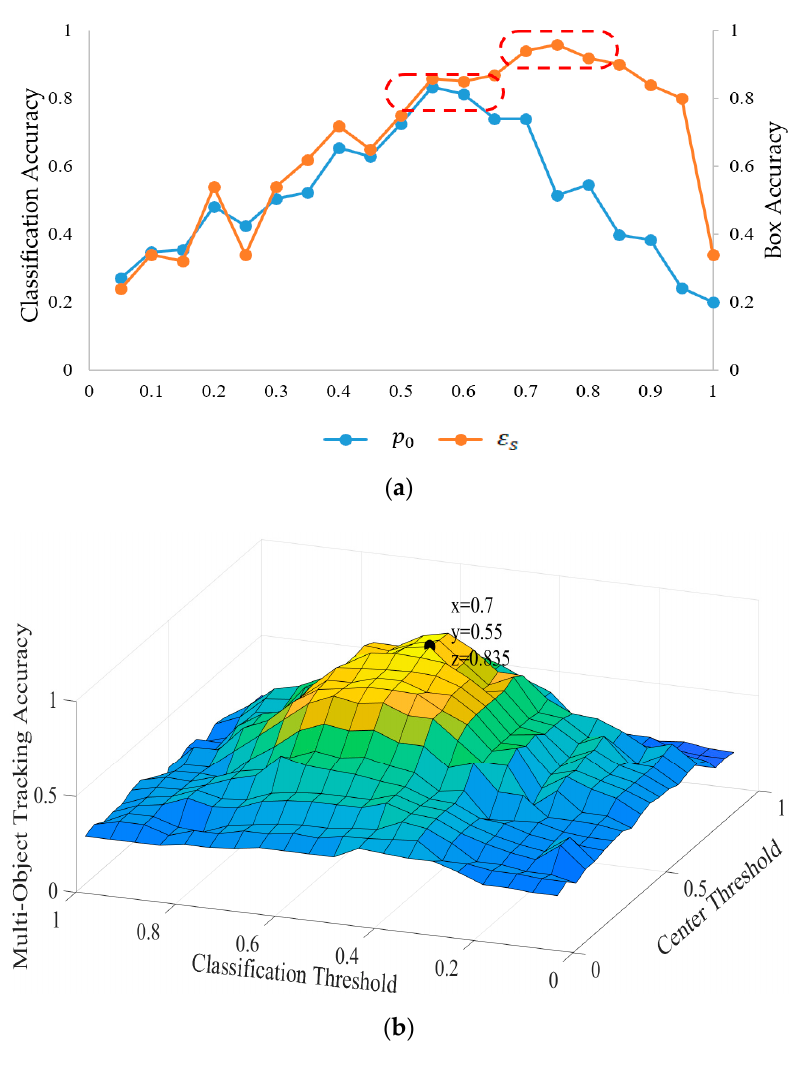
Figure 7. The selection of the global threshold ε s and classification threshold p 0 . ( a ) The relationship between the global center threshold ε s and the predicted bounding box accuracy. The result of classification accuracy of armored targets determined by the classification threshold p 0 . ( b ) The result of MOTA at di ff erent values of the global center threshold ε s and classification threshold p 0